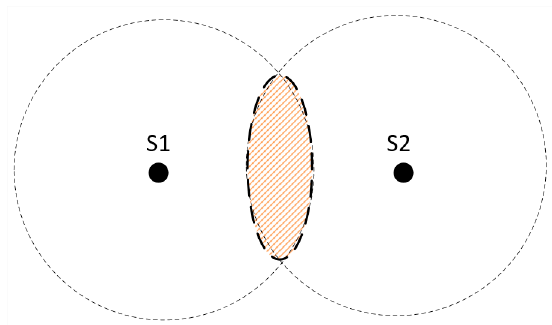
Figure 4. Proximity method concept.